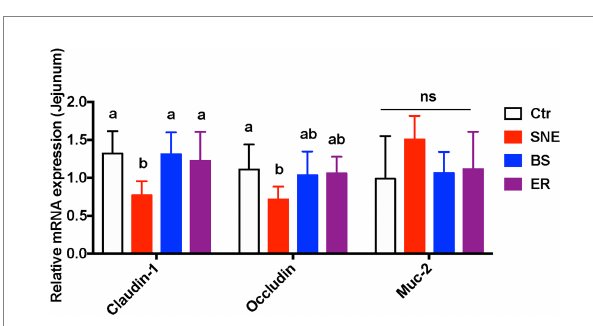
FIGURE 3 Changes on relative gene expression in the jejunum. (a, b) Mean values with unlike letters between different groups are significantly different ( p < 0·05). ns, not significant; SEM, standard error of mean. Each value represents the mean ± SEM of 12 replicates ( n = 12). The abbreviation of Ctr, SNE, BS and ER have the same meaning